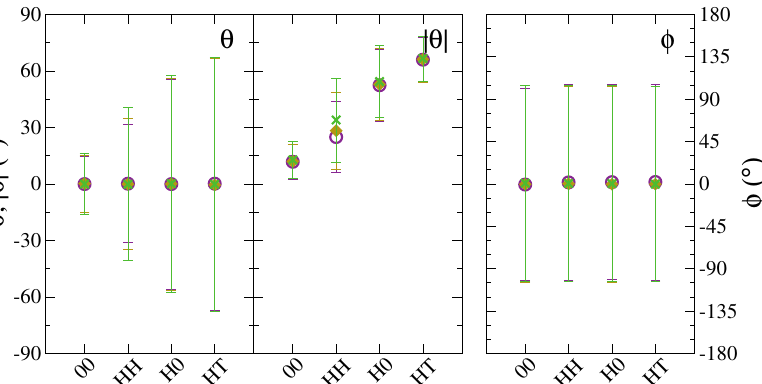
Figure 6. Polar ( (cid:104) θ (cid:105) , (cid:104)| θ |(cid:105) ) and azimuthal ( (cid:104) φ (cid:105) ) average angle values of particles (00, H0, HH and HT) at mass fractions 1wt% (empty purple circles), 5wt% (yellow diamonds) and 10wt% (green